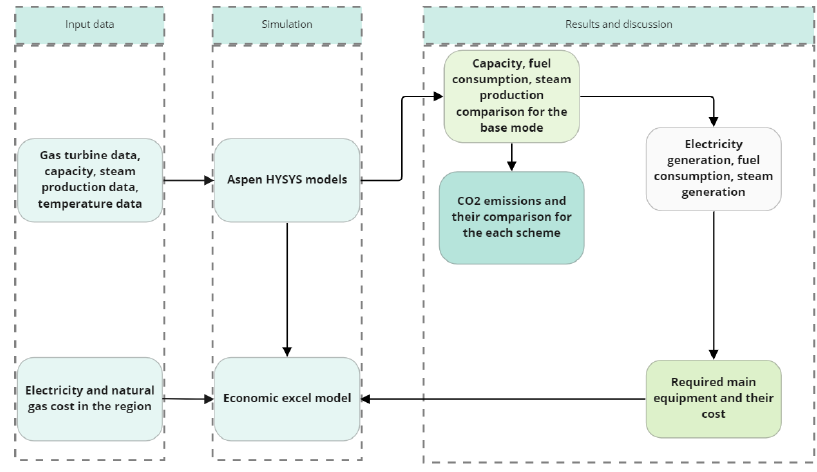
Figure 2. Methodology of the conducted research.